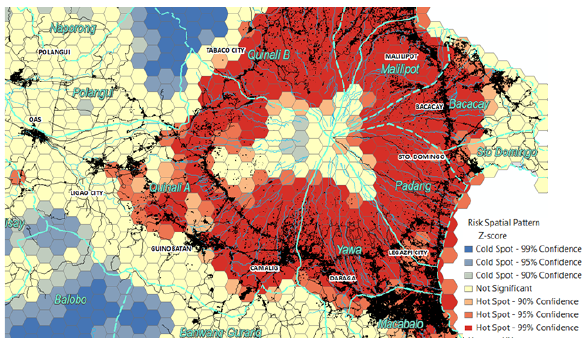
Figure 3. Exposed Buildings in parts of the Province of Albay